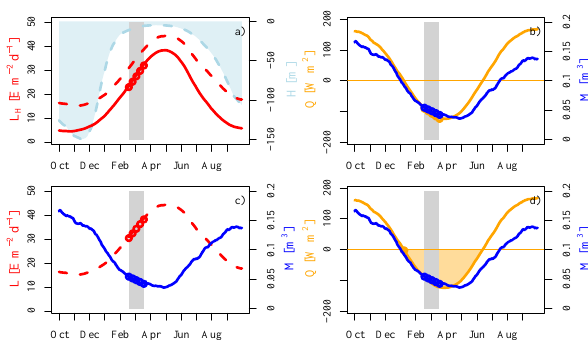
Figure 1. Definitions of each mechanism: (a) critical depth; (b) crit- ical turbulence; (c) critical light exposure; (d) critical heat flux (Ta- ble 1). Grey vertical area: 30 days prior to the date of climatologi- cal maximum rate of change in chlorophyll concentration; open cir- cles: average conditions during the 30 days. Lines show mixed-layer depth ( H , light blue), photosynthetic active radiation ( L , dashed red), integrated light over the mixed-layer depth ( L H , solid red), heat flux ( Q , orange), and wind-driven mixing ( M , dark